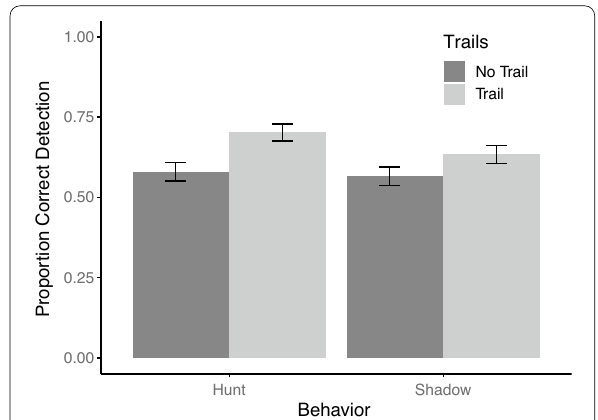
Fig. 2 Percentage of correct detections by behavior with and without history trails. Error bars represent one standard error